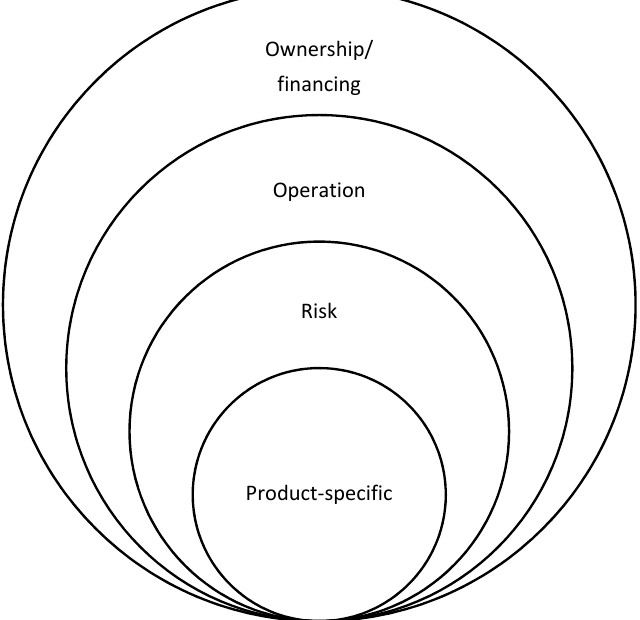
Figure 7. Types of barriers in accordance with the servitization potential and interdependence. The size of the circle depicts the tangibility associated with each category.